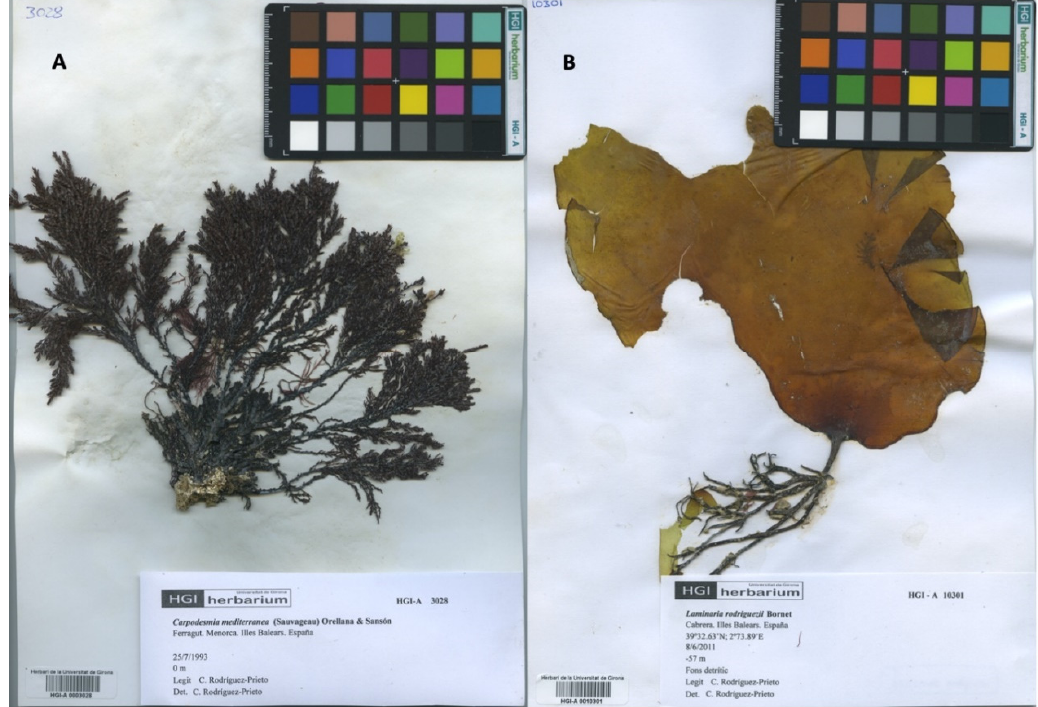
Figure 2. Specimens of Carpodesmia mediterranea (Sauvageau) Orellana and Sansón ( A ) and Laminaria rodriguezii Bornet ( B ) from the algae section of the herbarium of Universitat de Girona (HGI-A).